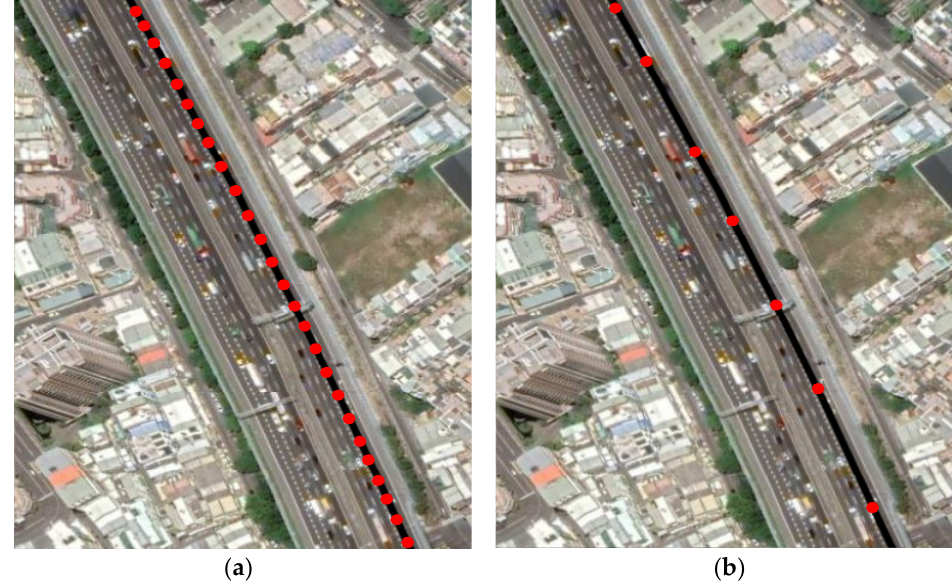
Figure 32. GPS test of vehicle driving in a straight line: ( a ) one GPS datum is recorded every 0.5 s; ( b ) record GPS data when acceleration occurs.